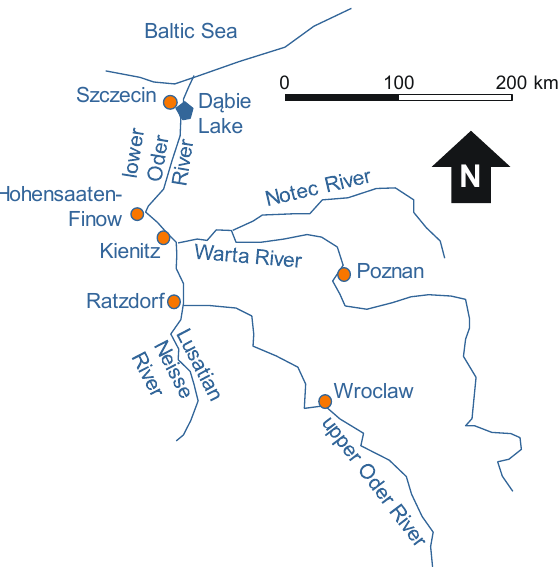
Figure 11. Main stem of the Oder River and its major tributaries (drawn by the first author). Icebreaking on the Oder River continues upstream towards the mouth of the Warta River, where the resources are split, with the larger part of the icebreaker fleet continuing breakage along the Oder River towards the Lusatian Neisse River mouth and the remain- ing icebreaker force working its way up the Warta River to the Notec River mouth. Cau- tion must be taken not to begin breakage operations too early so as not to create a large amount of ice floes flowing from the upper sections of the Oder River and its tributaries to the lower reach of the Oder River to create ice jams and, thus, risk inducing a flood artificially. 5.2. Flood Warning under Ice Conditions Operational flood warning relies on river gauge monitoring. The federal state of Brandenburg, Germany defines four different flood alert levels, which are specified for representative river gauges used in flood reporting services, see Figure 12. An alert level is proclaimed when water levels exceed a certain alert stage and local authorities must take action. The alert levels require increasing operational flood defense actions with in- creasing water stages [20]: alert level AI—water level reporting service (German: Meldebe- ginn ), AII—control service at flood defense infrastructure such as dikes (German: Kontrolldienst ), AIII—guard duty (German: Wachdienst ), and AIV—civil protection (Ger- man: Hochwasserabwehr ). These four alert levels allow quick assessment of the potential severity of a flood across different rivers in Brandenburg. The gauges used for the alert level system require high reliability and redundancy of sensors and communication net- works. Figure 12. Alert levels for flood warnings (source: Landesamt für Umwelt Brandenburg).